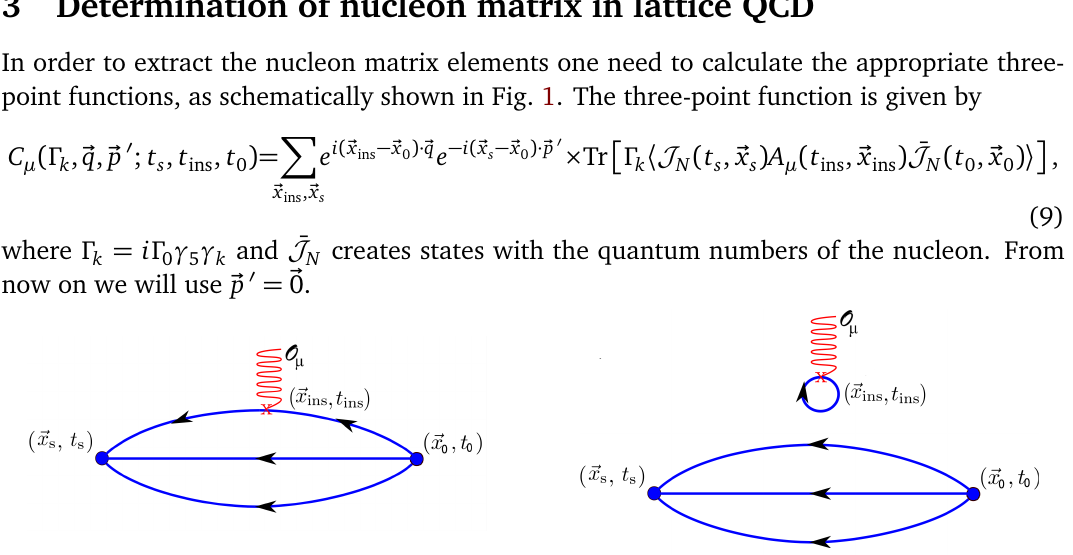
Figure 1: Diagrammatic representation of three-point functions (left: connected, right: disconnected) needed for the determination of nucleon matrix elements. O